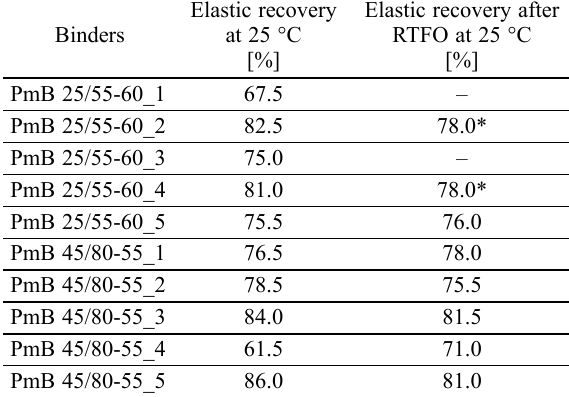
Table 1. Elastic recovery for polymer modified